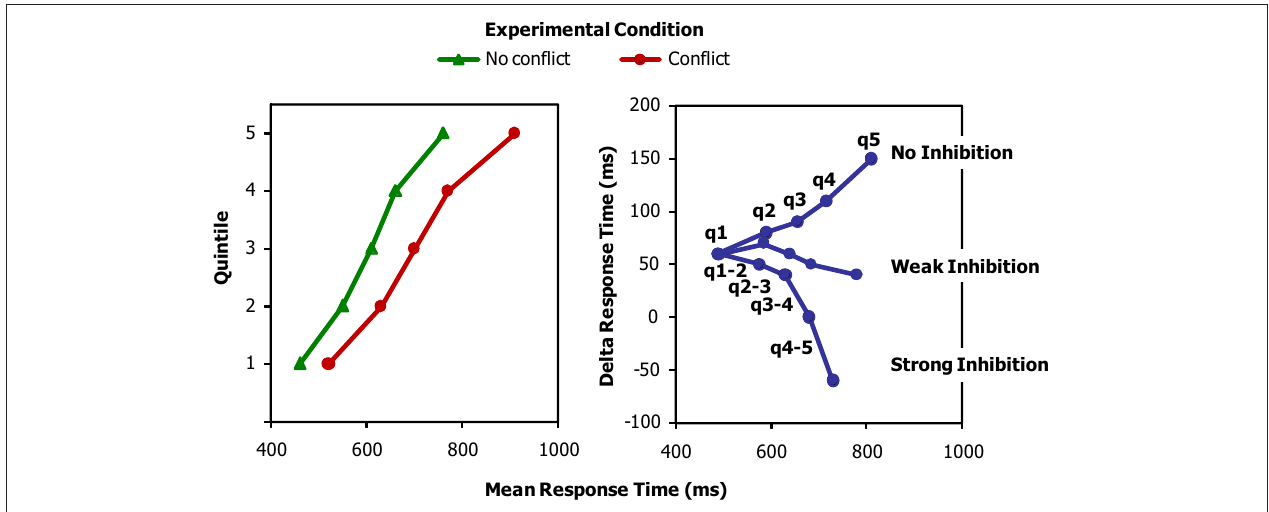
Figure 1 | Left panel: cumulative distribution curves for response times in experimental conditions with and without conflict. Right panel: delta plots showing the condition differences (deltas) as a function of quintile (1–5) and amount of inhibition (no, weak, strong) . q1, quintile 1, and so forth; q1–2 is the segment connecting quintiles 1 and